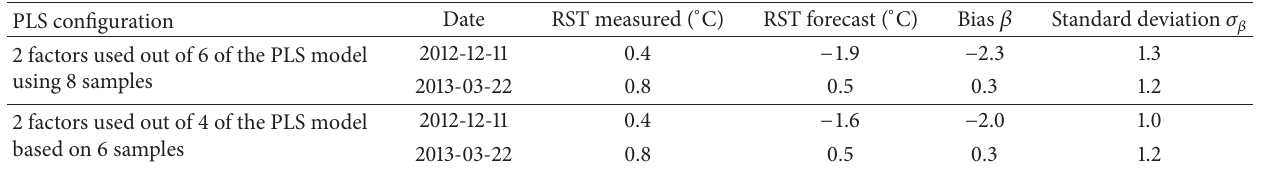
profiles for two dates. air